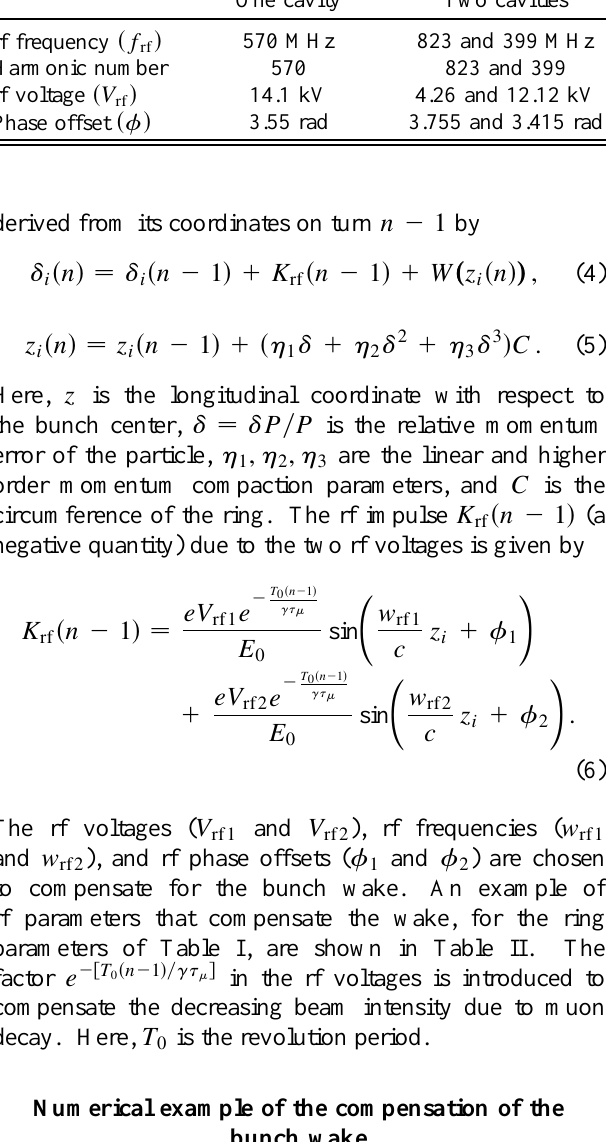
TABLE II. rf cavity parameters for wake compensation. One cavity